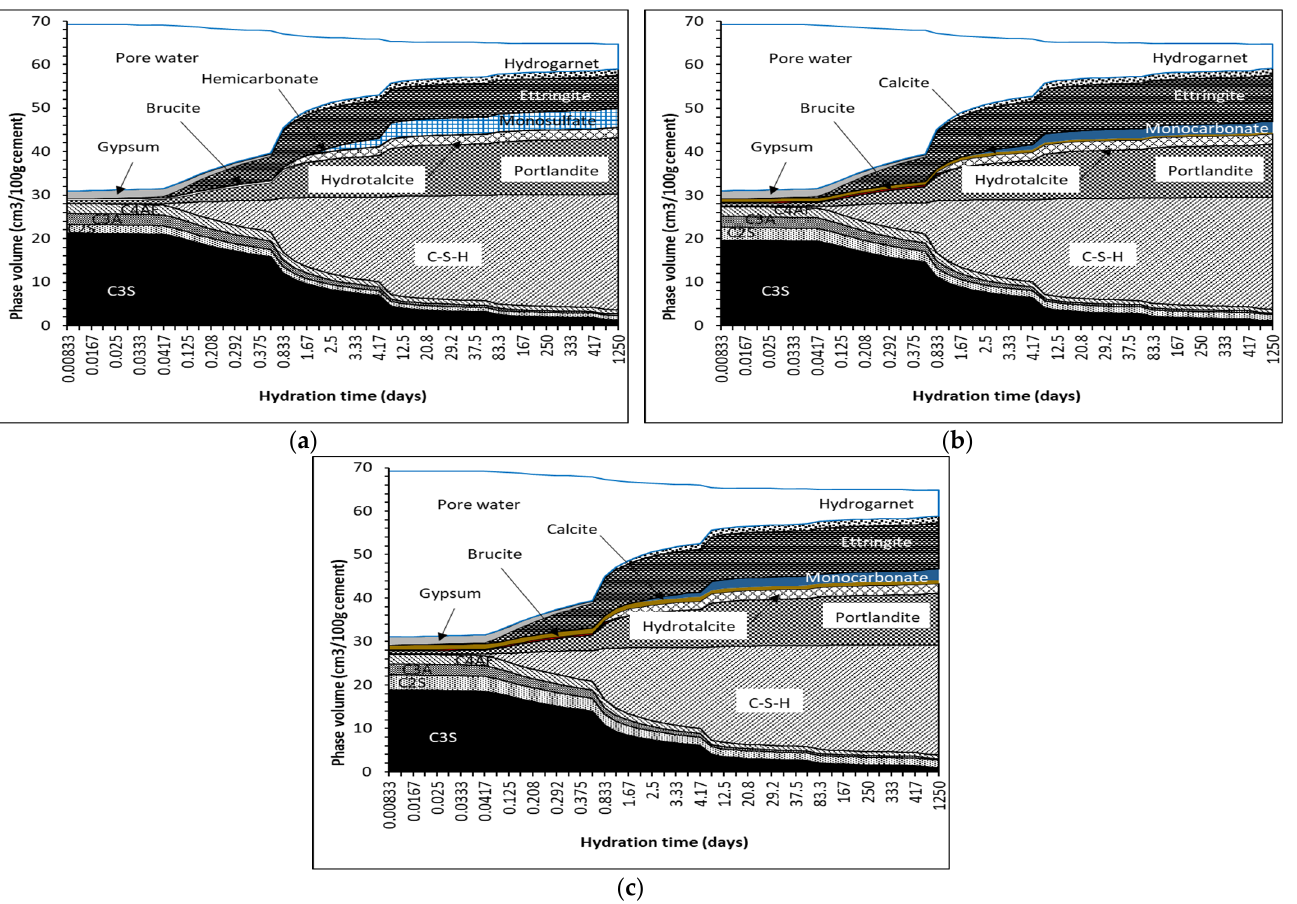
Figure 16. Typical thermodynamic phase assemblages for ( a ) 0%, ( b ) 2% and ( c ) 5% calcite.